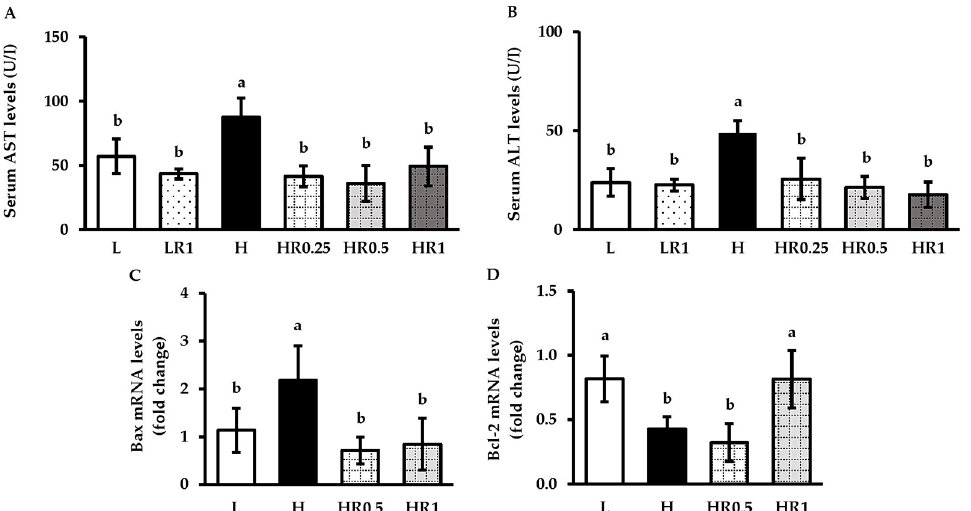
Figure 6. Effects of RRBE on hepatic injury and apoptotic markers in mice fed with experimental diets: ( A ) serum AST levels; ( B ) serum ALT levels; ( C ) liver Bax mRNA levels; ( D ) liver Bcl-2 mRNA levels. Values are means ± SD; 4–6 mice/group. Statistically significant difference at p < 0.05 was analyzed using one-way ANOVA with Tukey’s test and is indicated by different letters above error bars. The L, LFD, and distilled water co-treated group; LR1, LFD, and high-dose (1 g/kg) RRBE co-treated group; H, HFD, and distilled water co-treated group; HR0.25, HFD, and low-dose (0.25 g/kg) RRBE co-treated group; HR0.5, HFD, and middle-dose (0.5 g/kg) RRBE co-treated group; HR1, HFD, and high-dose RRBE co-treated